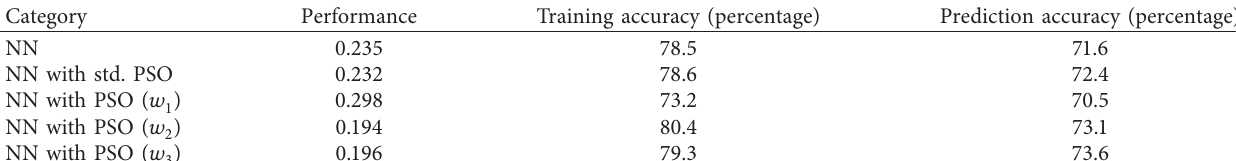
Table 4: Summary of the performance relating to different models.